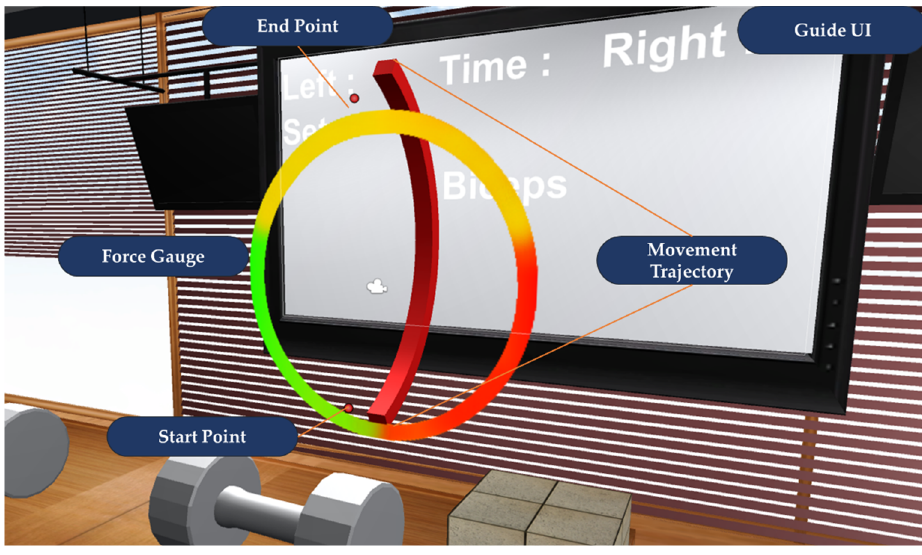
Figure 7. FGCGUI. Figure 7. FGCGUI.